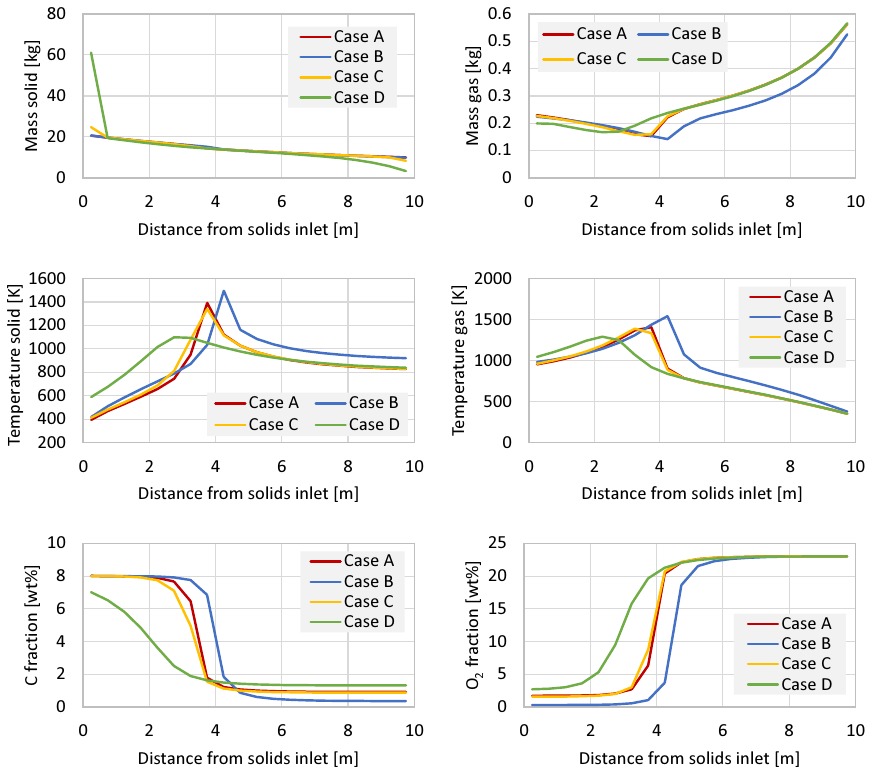
Figure 13. Influence of wall temperature and back-mixing on the simulation results. Solid and gas mass ( top ), solid and gas temperature ( middle ), organic residue concentration ( bottom left ), and oxygen concentration ( bottom right ) along the kiln after reaching steady-state.